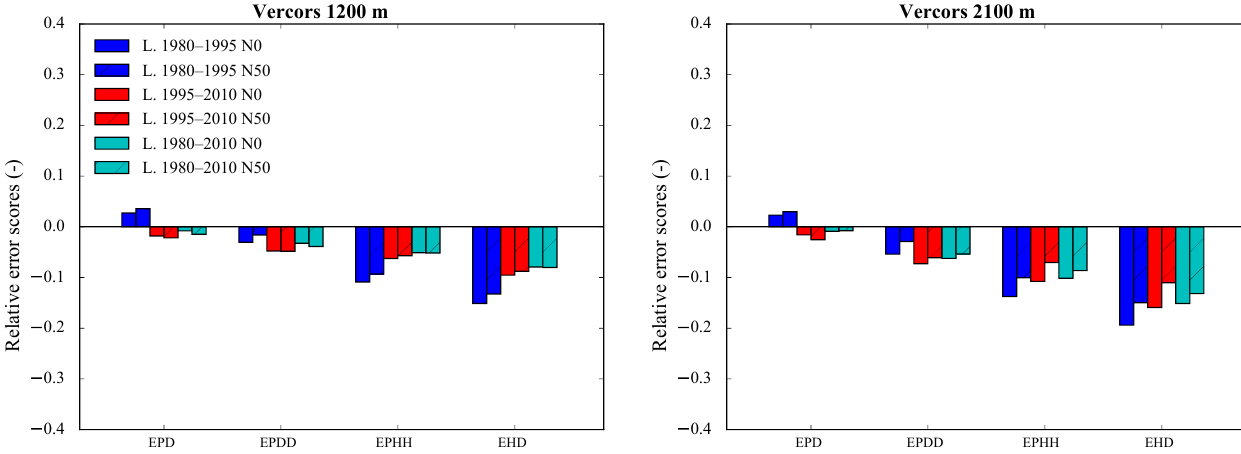
Figure 10. Scores for the duration and persistence of precipitation events in each adjusted RCM simulation compared to the SAFRAN reanalysis over the evaluation period for the Vercors massif at 1200 and 2100ma . s . l . EPD is the relative error on the probability of a dry day, EPDD is the relative error on the probability of a dry day following a dry day, EPHH is the relative error on the probability of a wet day following a wet day and EHD is the relative error on the mean duration of wet